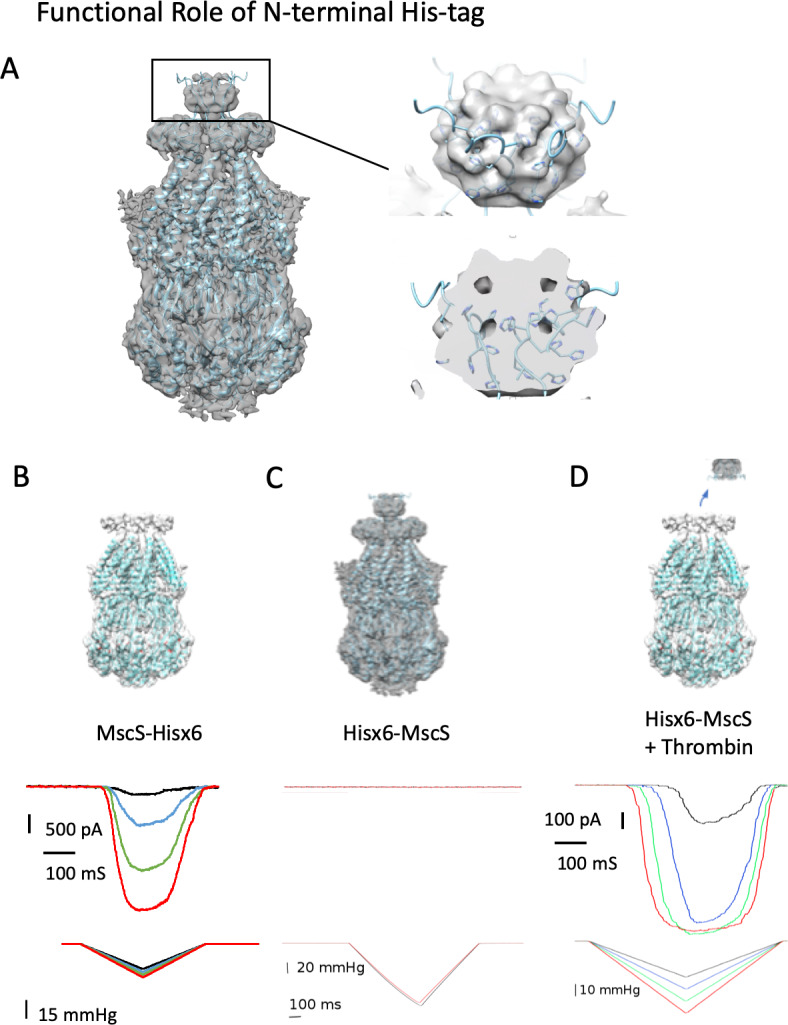
Functional consequences of an N-terminal 6xHis-Tag.(A) 3D refined model from Figure S2 without masking the His-tag region. Insets show a 45-degree view of the 6xHis tag density (top) and a center section (bottom). The his-tag residues were modeled using coot and molecular dynamic flexible fitting (Ref). (B) As stable 6xHis tag ‘crown’ oligomer inhibits MscS opening. High-speed pressure clamp recordings of reconstituted MscS in HEK296 DMPC:DMPG 3:1. Families of macroscopic currents, elicited by pressure ramps are shown for Wt-MscS with the 6x His-Tag at its C-terminal (C) MscS with the 6x His-Tag at its N-terminus and (D) MscS with the 6x His-Tag after Thrombin cleavage. These data strongly suggest that the N-terminal anchor domain likely separates (in the plane of the bilayer) upon MscS opening.